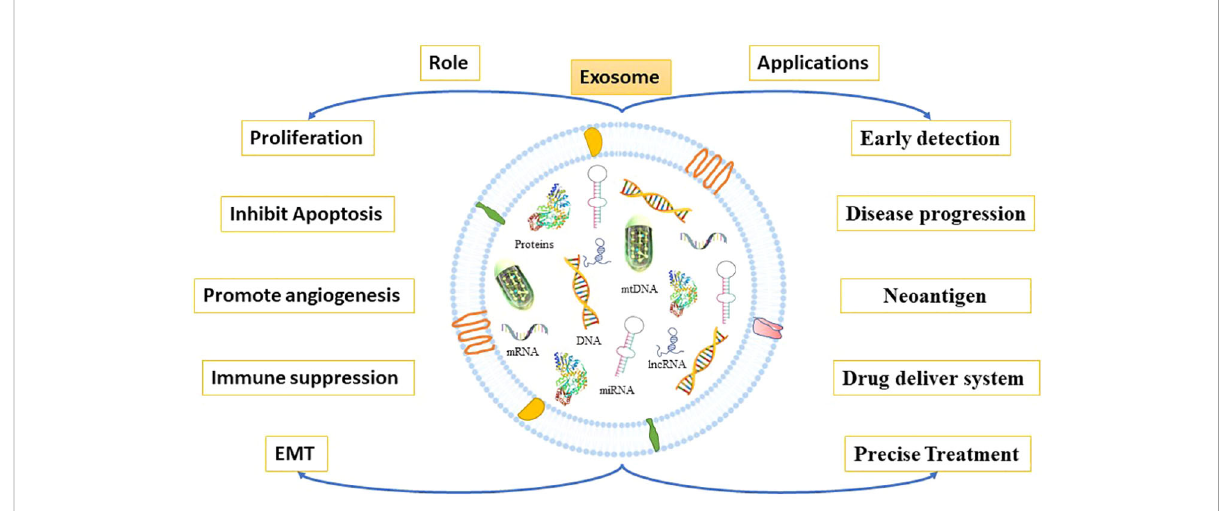
FIGURE 5 Roles and application of exosomes. Tumor-derived exosomes promote cancer growth and metastasis. Through multiple mechanisms, they participate in cancer growth and metastasis by reshaping TME resulting into EMT, cell proliferation, apoptosis inhibition, immunosuppression, and angiogenesis. Exosomes derived from cancer cells are enriched with proteins, mRNA, miRNA, lncRNA, DNA etc. that are more abundant in cancer cells than in normal cells. Thus, exosomes may be used as biomarkers for cancer diagnosis, prediction, and